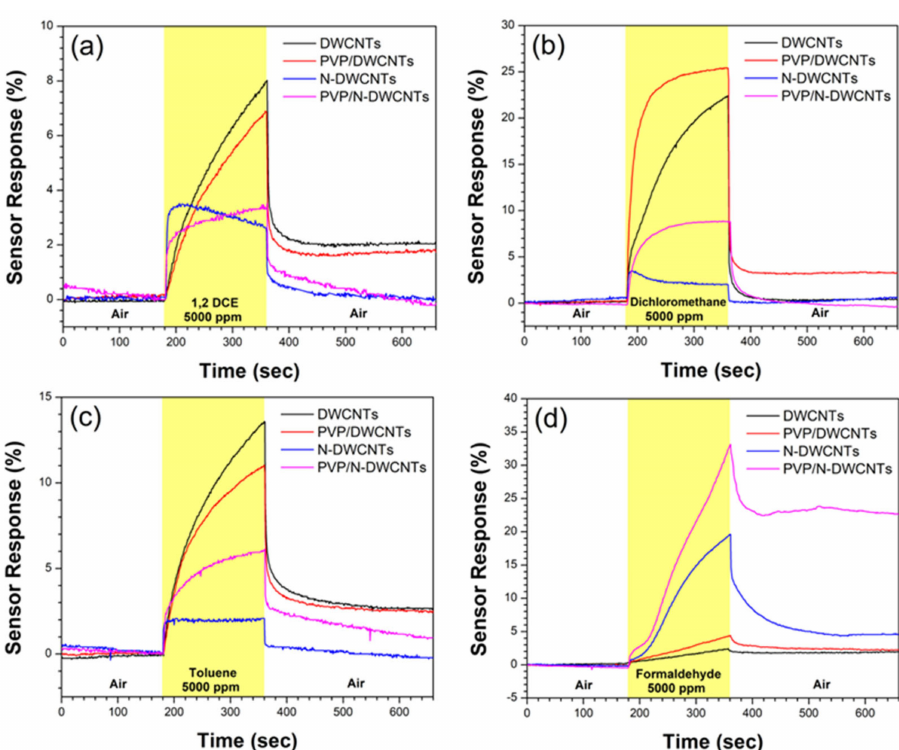
Figure 4. Sensor response of all sensors as a function of time exposed to ( a ) 1,2-dichloroethane, ( b ) dichloromethane, ( c ) toluene, and ( d ) formaldehyde at 5000